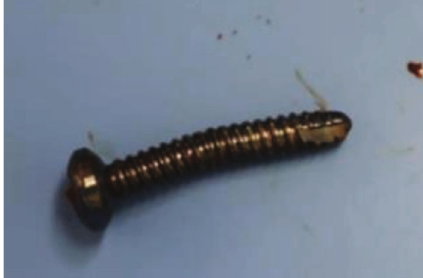
Figure 8: The compression screw removed after bone union was bent because of the compression